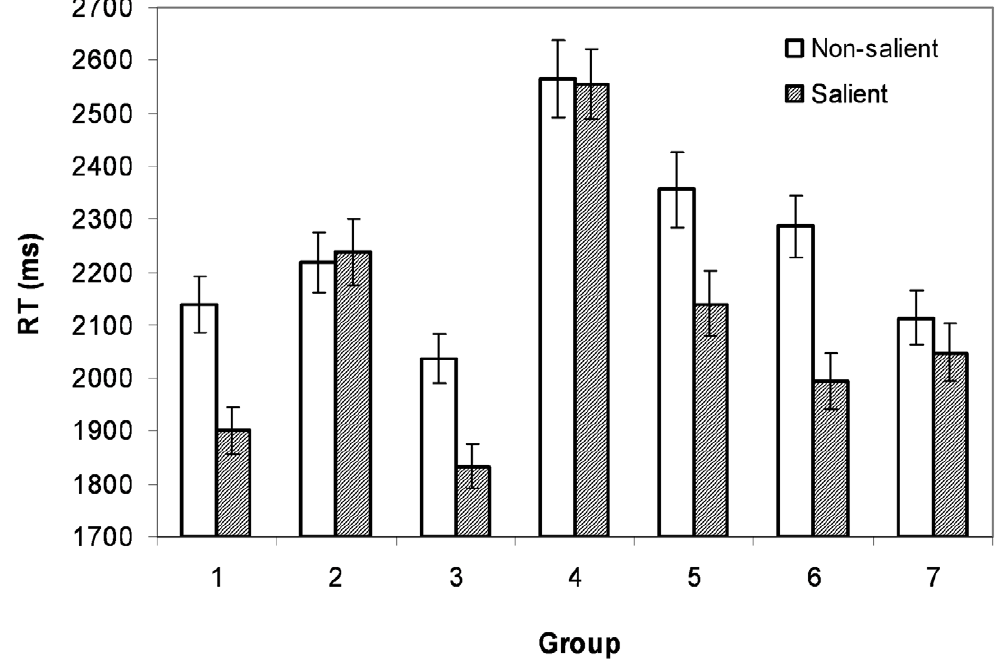
Figure 2. Reaction time in Experiment 1 based on salience and group variables. The error bars are standard errors. doi:10.1371/journal.pone.0010442.g002 PLoS ONE |